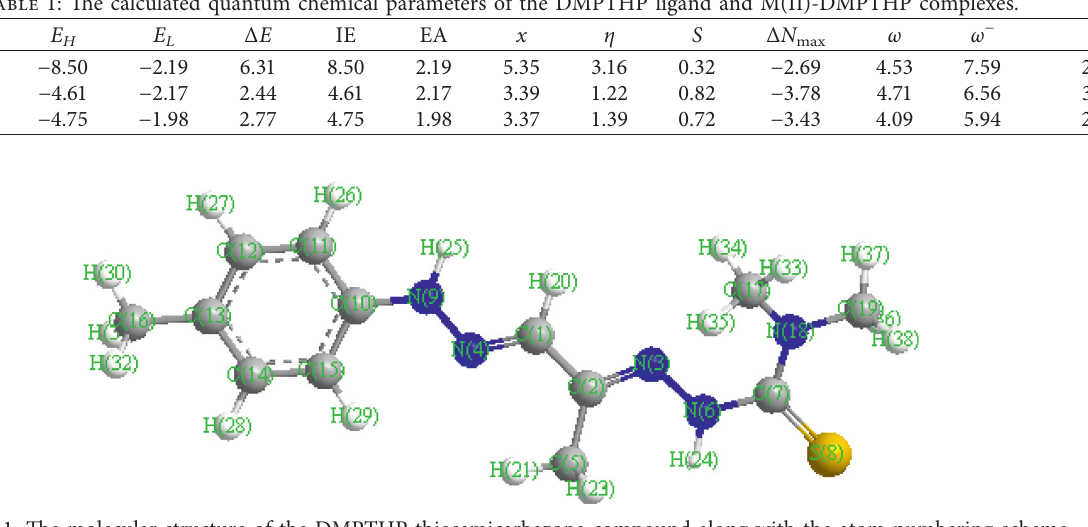
Figure 1: The molecular structure of the DMPTHP thiosemicarbazone compound along with the atom numbering scheme.